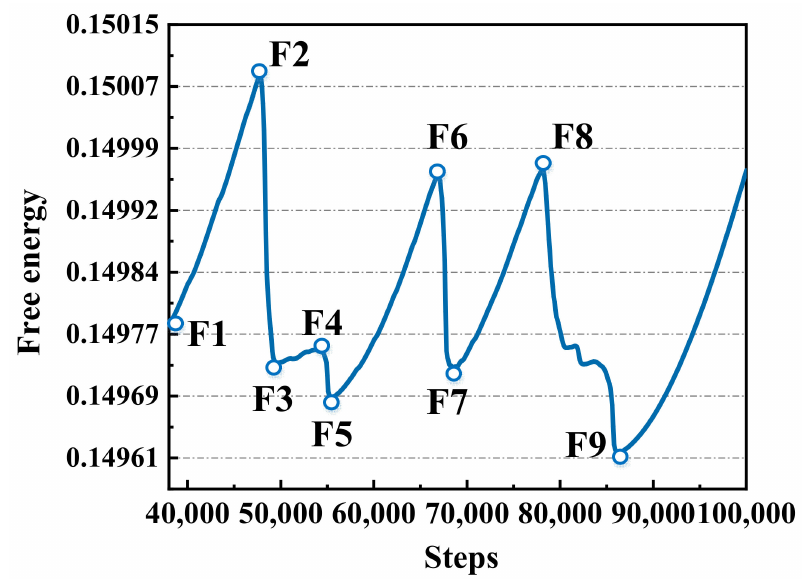
Figure 8. Free energy curve of the dislocation evolution in sample B. F1–F9 represent energy value points.